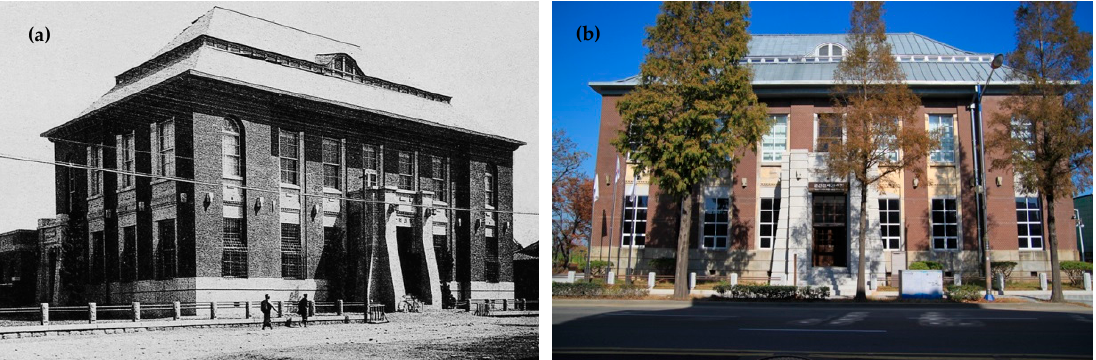
Figure 2. ( a ) Gunsan’s former branch of Chosun Bank, 1922. ( b ) Modern Architecture Centre, opened in 2013 after restoration (©Gunsan City).